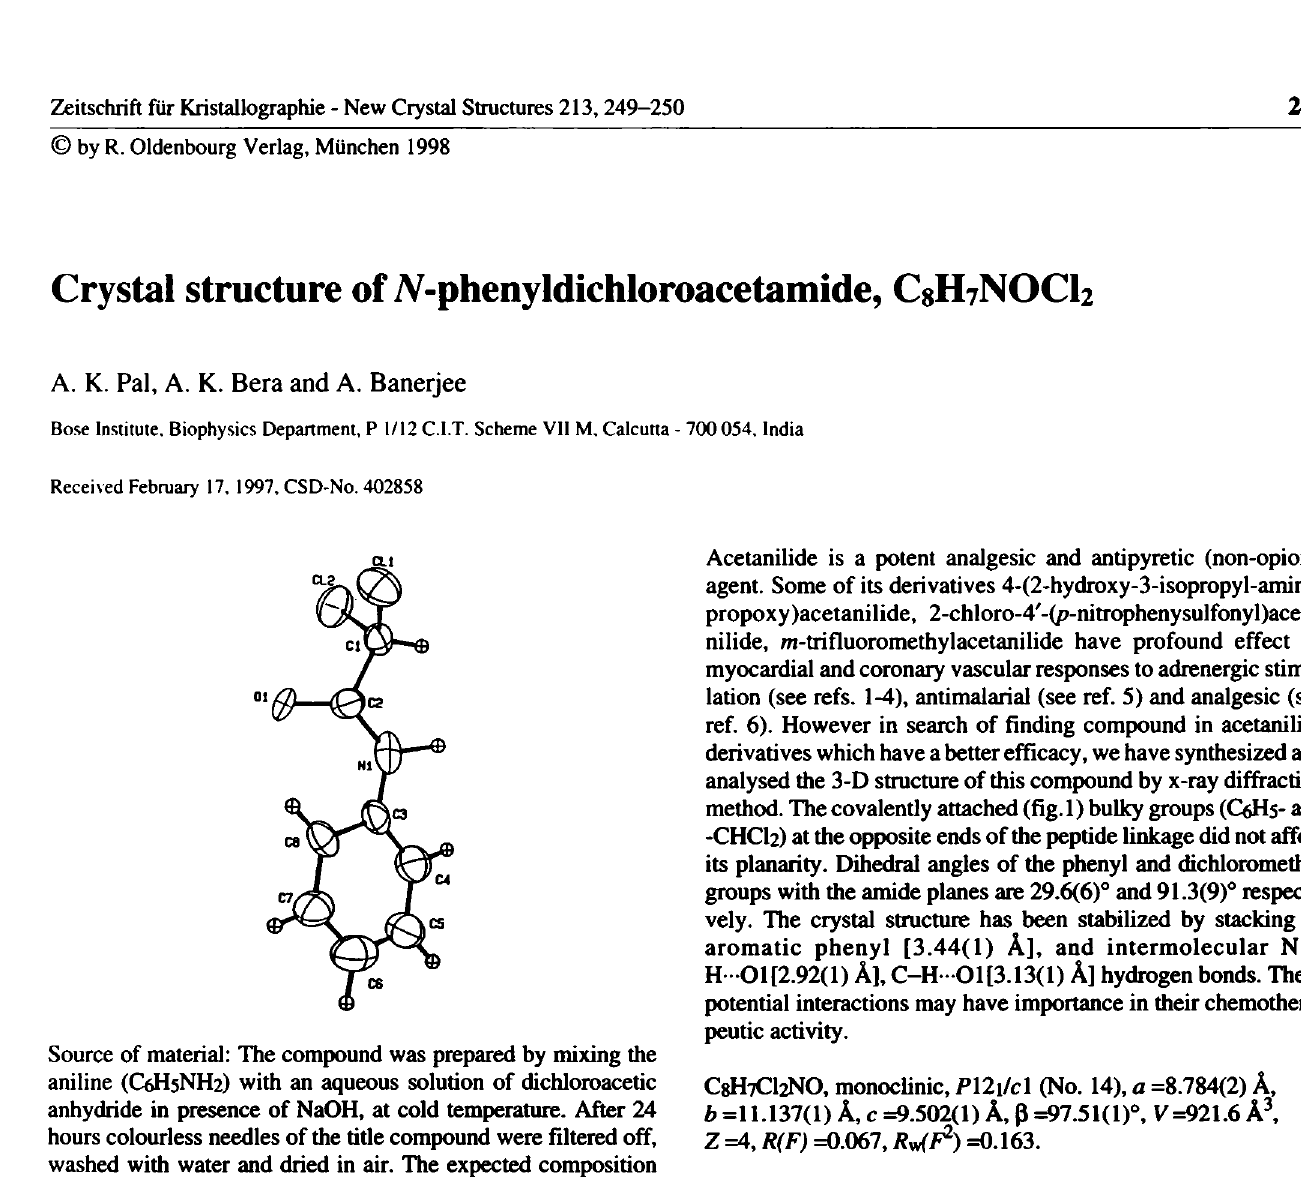
Table 2. Final atomic coordinates and displacement parameters (in Â^)